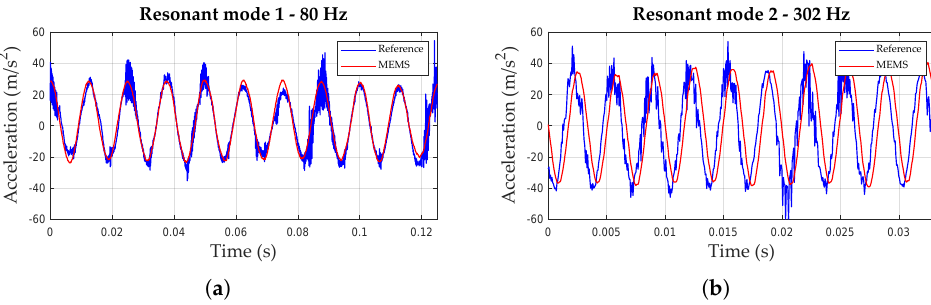
Figure 3. Plots of accelerations measured over time in the case of: ( a ) the first resonant mode at a rotor speed of 180 rpm and ( b ) the second resonant mode at 300